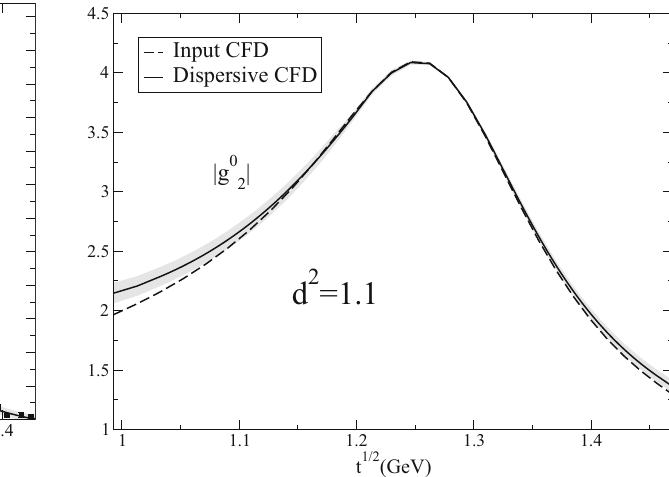
dispersion relation in 2